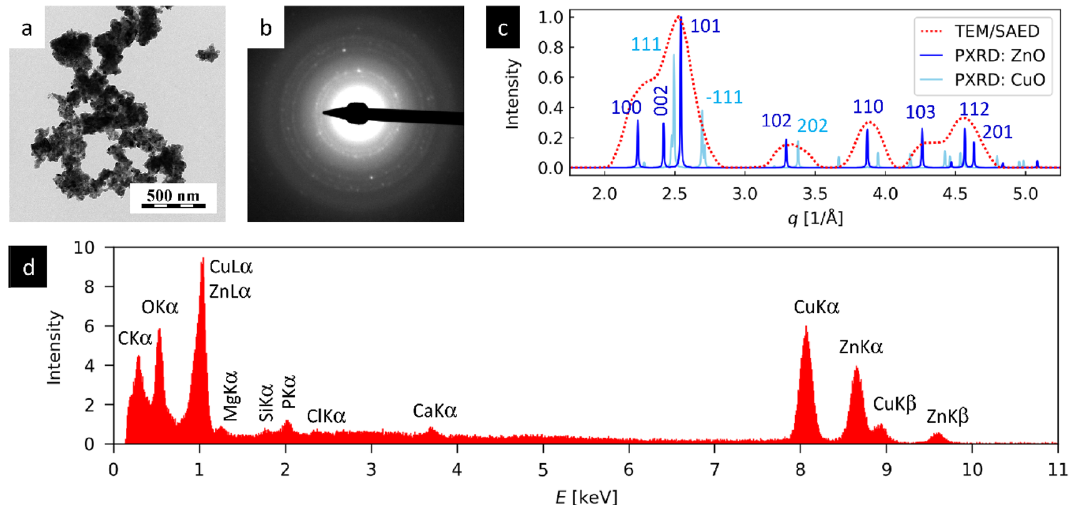
Figure 3. TEM analysis of ZnO/CuO NPs: ( a ) TEM/BF image demonstrates the morphology of NPs, ( b ) TEM/ SAED diffraction pattern, ( c ) the comparison of radially averaged experimental TEM/SAED diffractogram with theoretically calculated power XRD diffractograms of ZnO and CuO nanocrystals, and ( d ) TEM/EDX spectrum of bimetallic ZnO/CuO NPs.